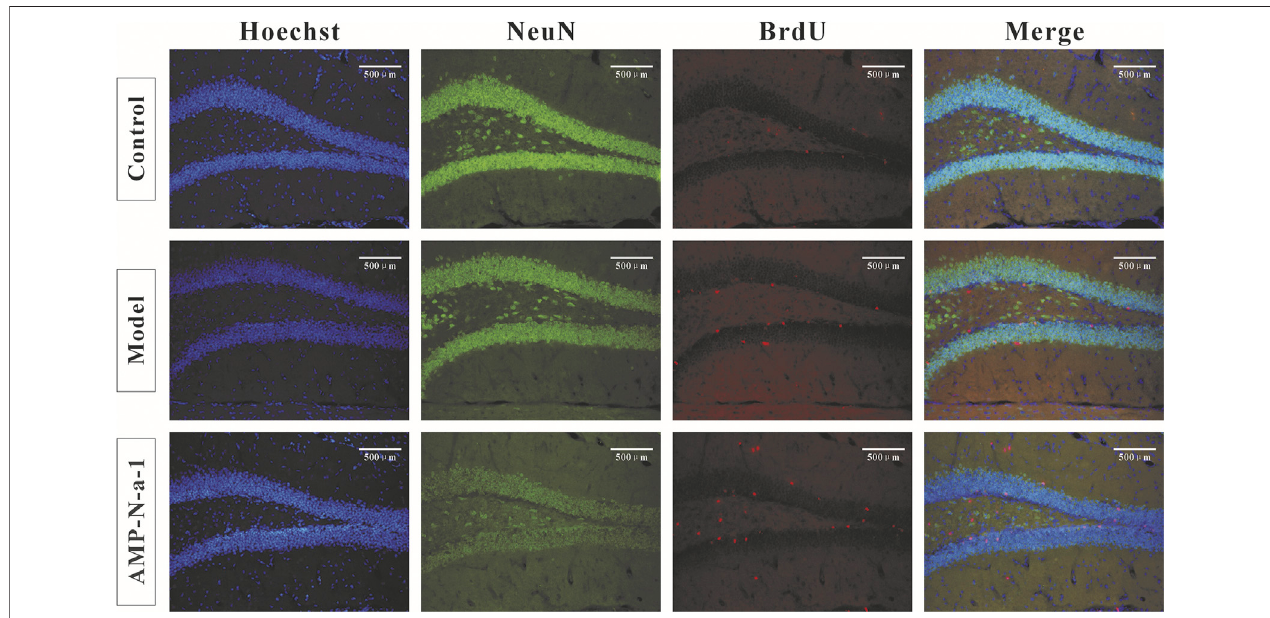
FIGURE 3 | Double BrdU/NeuN expressions in the hippocampal dentate gyrus in the control group, model group, and 0.1 g kg − 1 AMP-N-a-1 group.